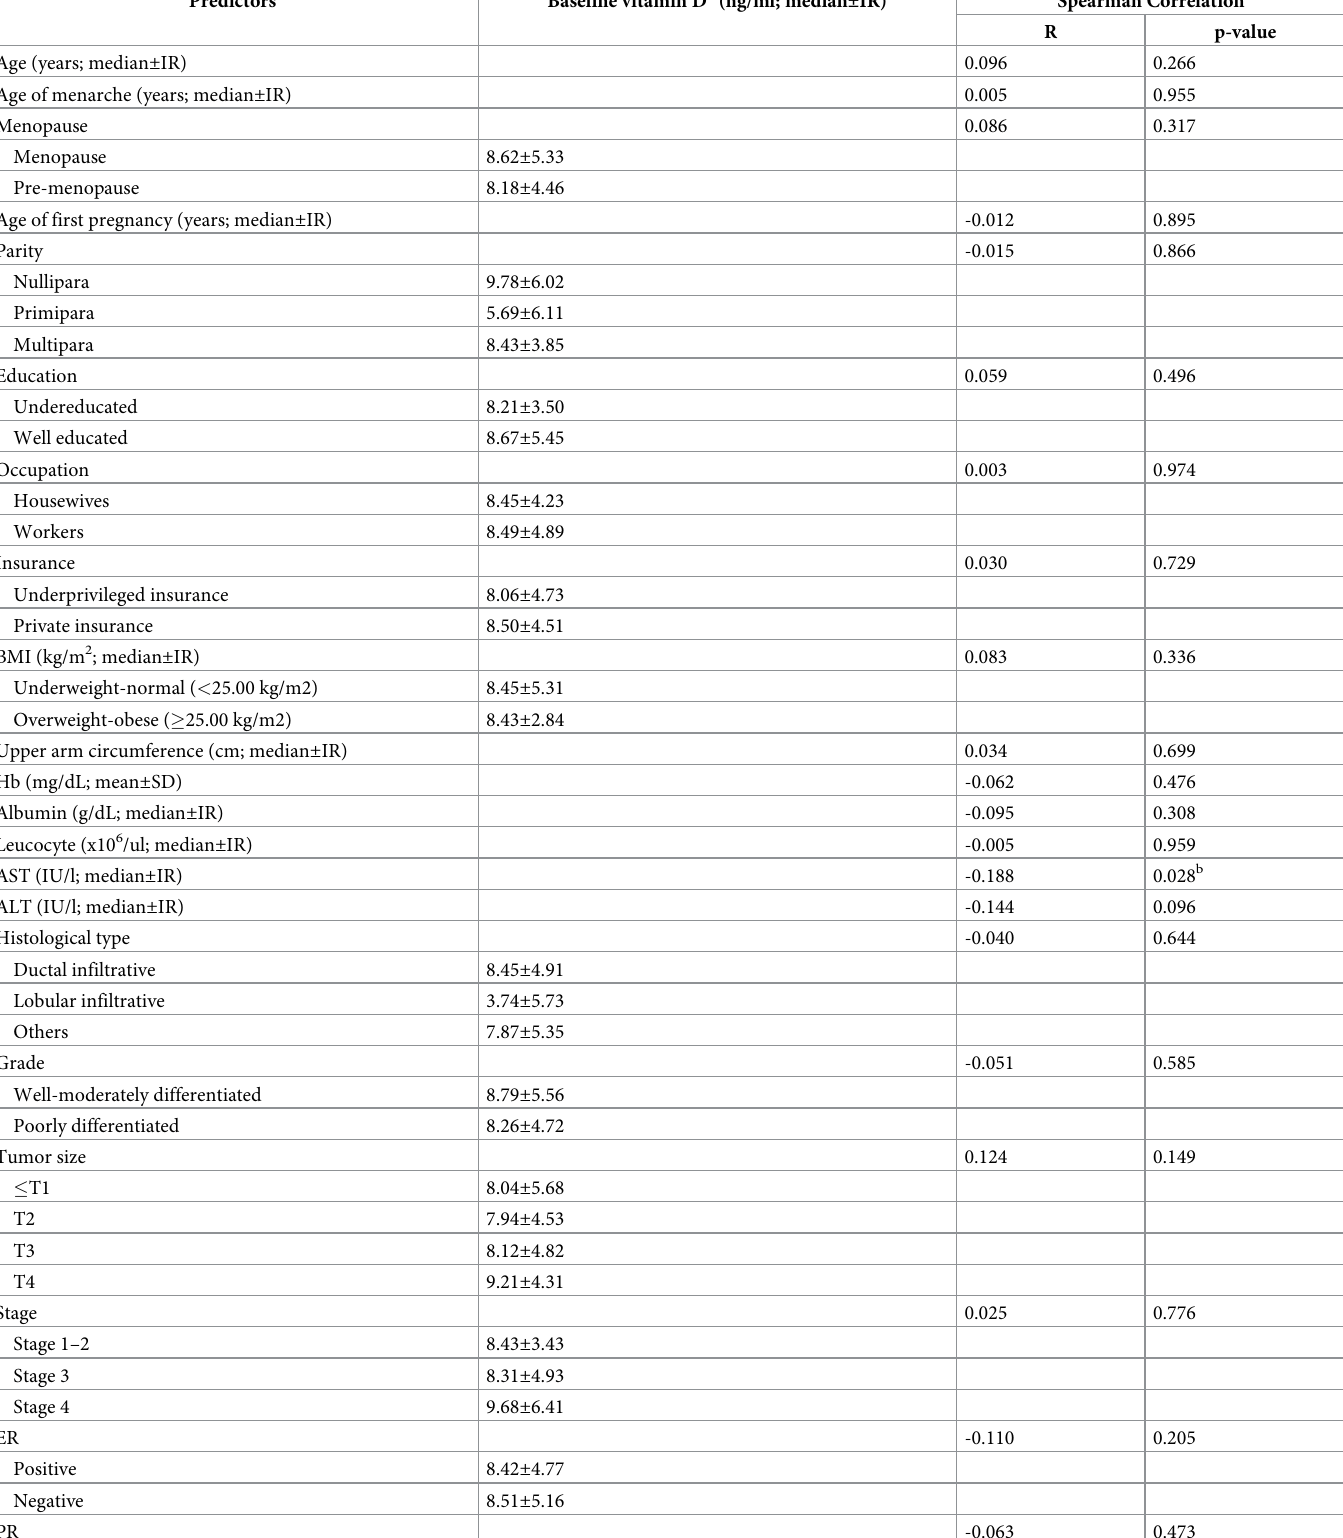
Table 2. Correlation between baseline vitamin D level with socio-demographic factors and clinicopathology characteristics (n =